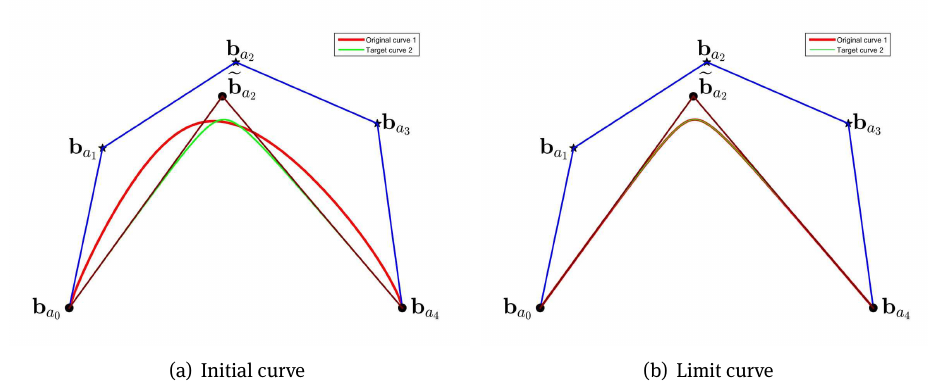
Figure 9: Limits of the quadratic GT-Bézier curve with multiple